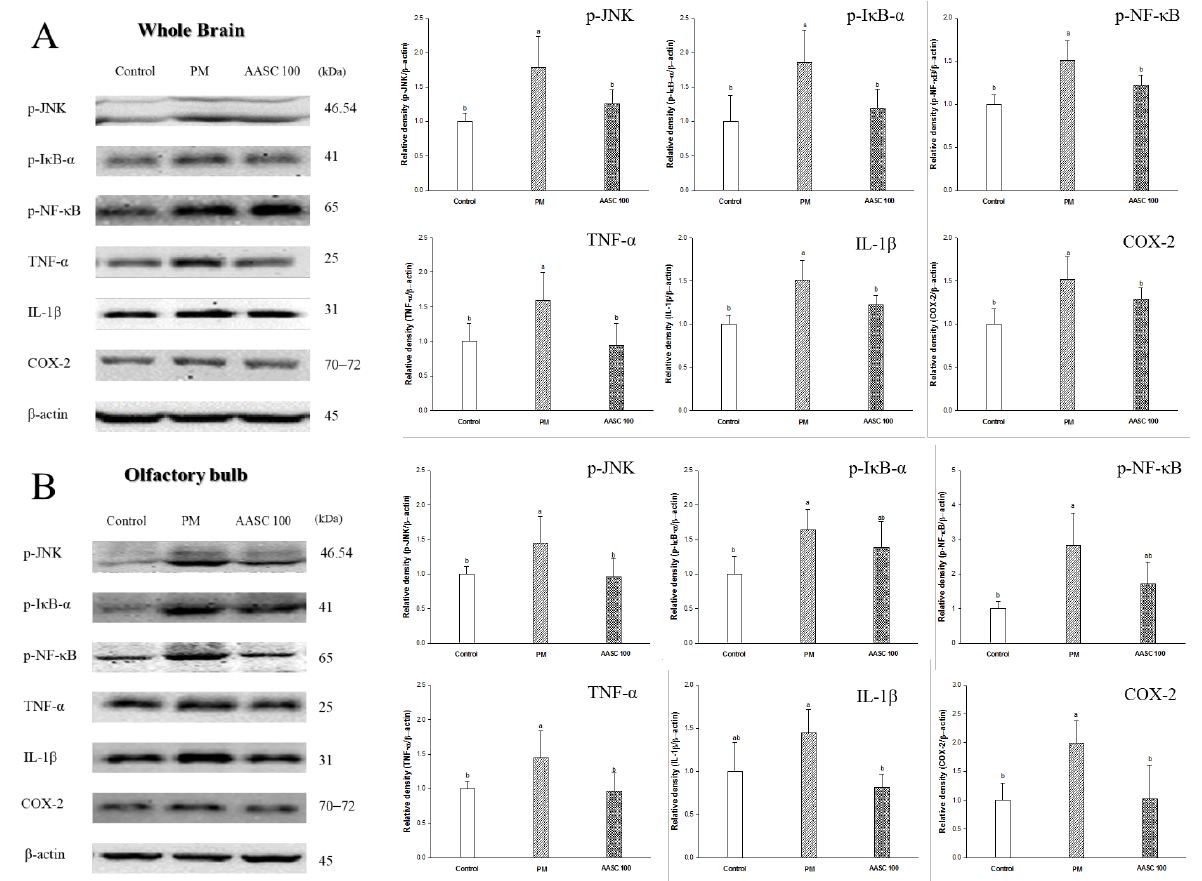
Figure 5. The effect of AASC on proteins related to inflammation in the brains of mice exposed to PM 2.5 . ( A ) Whole brain and ( B ) olfactory bulb. Results are indicated as mean ± SD ( n = 8). Different small letters represent the statistical difference ( p < 0.05) of each group in a high order.